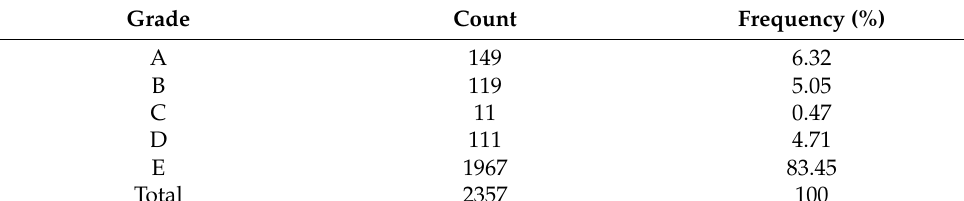
Table 1. Summary results of Bovidae dataset downloaded from BOLD on 10 November 2020.